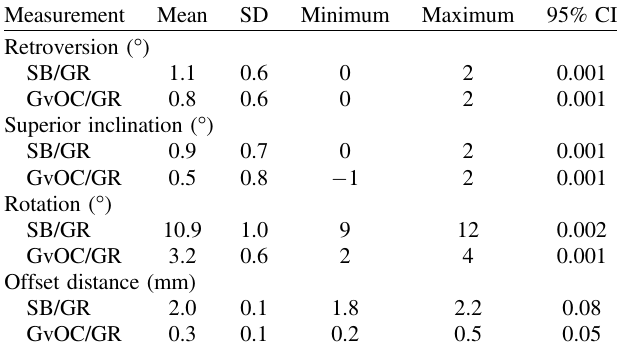
Table 2. Intra-observer reproducibility tests for SB/GR GvOC/GR planes position calculations in one scapula.